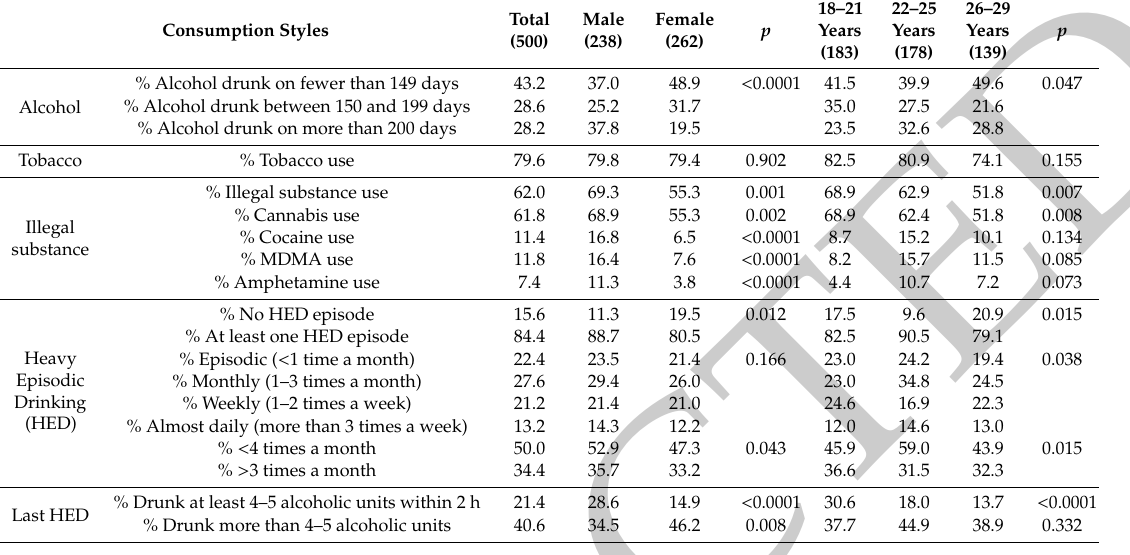
Table 1. Consumption styles in the last